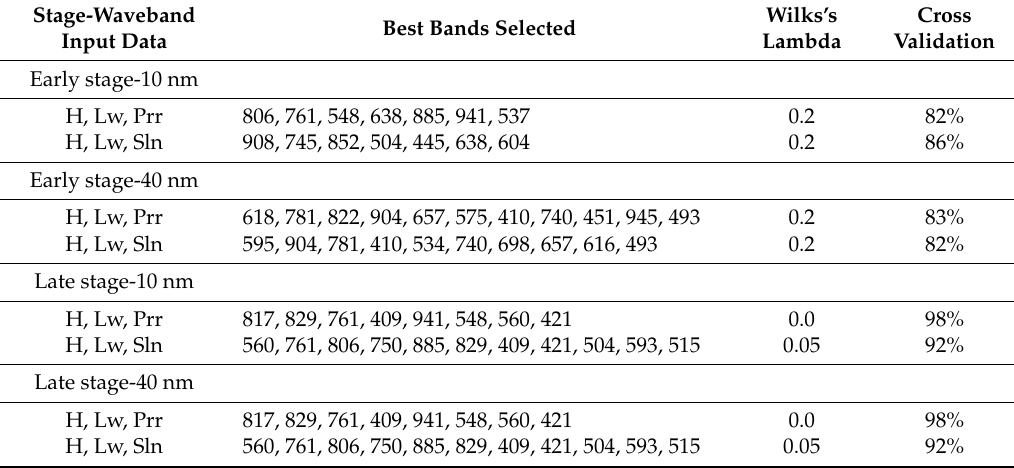
Table 4. Hyperspectral classification of laurel wilt (Lw), Healthy (H), Phytophthora root rot (Prr), and salinity damage (Sln) and the best wavebands selection using stepwise discriminant (STEPDISC) analysis for different growth